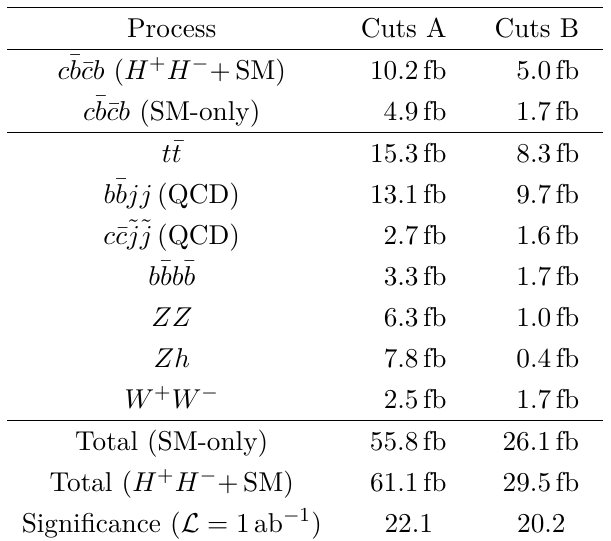
Table 1 . Cross sections in fb of the interfering Signal and rest of the backgrounds. We also show ¯ c b ¯ cb contribution for SM only after Cuts A and Cuts B. See text for more details.